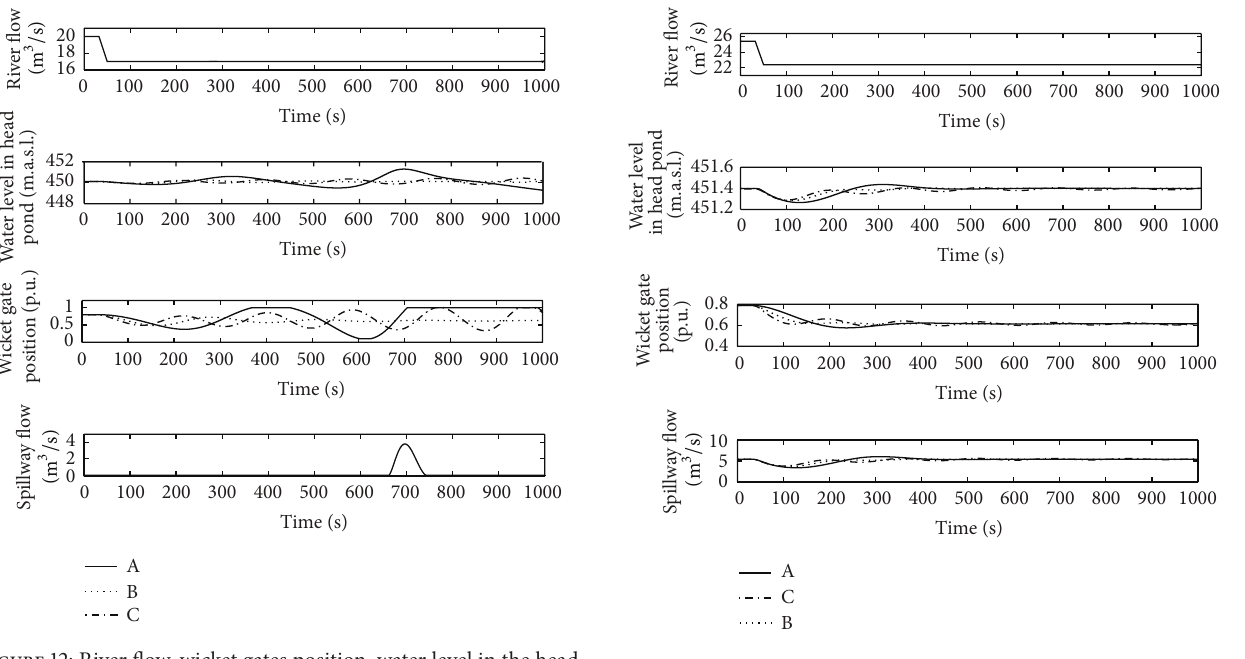
Figure 13: River flow, wicket gates position, water level in the head pond, and spillway flow, in flood operation (points A, B, and C).